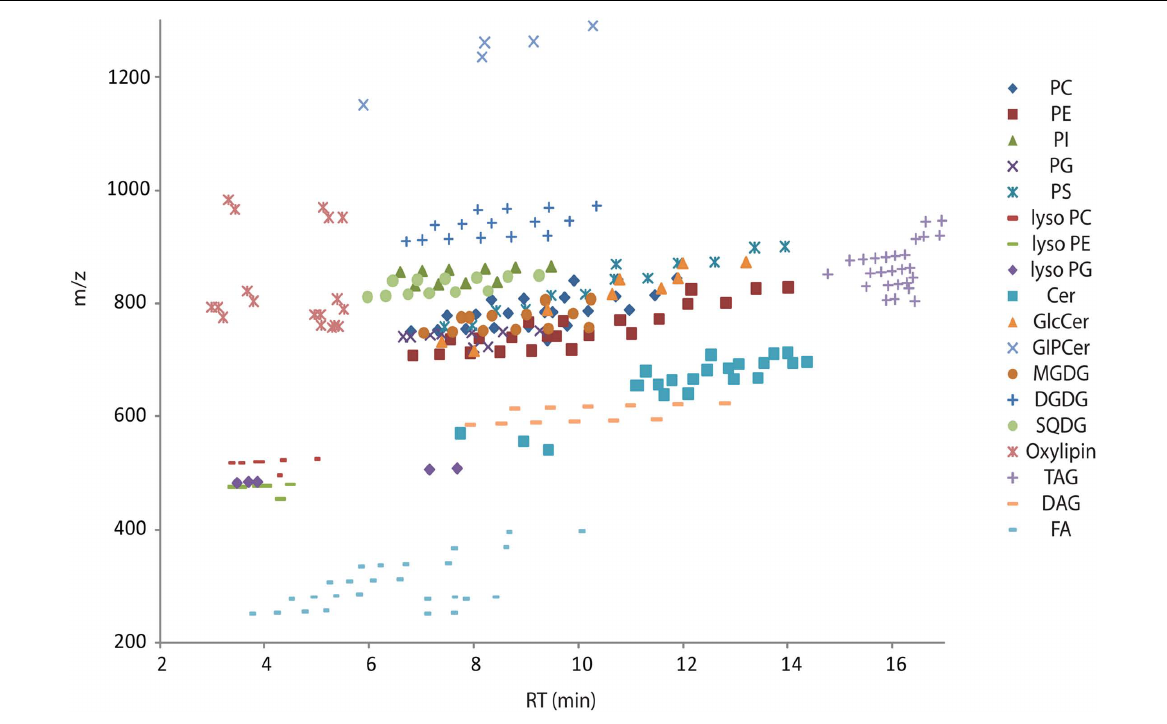
right. Abbreviations are as follows: PC, phosphatidylcholine; PE, phosphatidylethanolamine; PG, phosphatidylglycerol; PI, phosphatidylinositol; PS, phosphatidylserine; MGDG, monogalactosyldiacylglycerol; DGDG, digalactosyldiacylglycerol; SQDG, Sulfoquinovosyldiacylglycerol; Cer, ceramide; GlcCer, glucosylceramides; GIPC, glycosylinositolphosphoceramides;TAG, triacylglycerols; DAG, diacylglycerols; FA, fatty